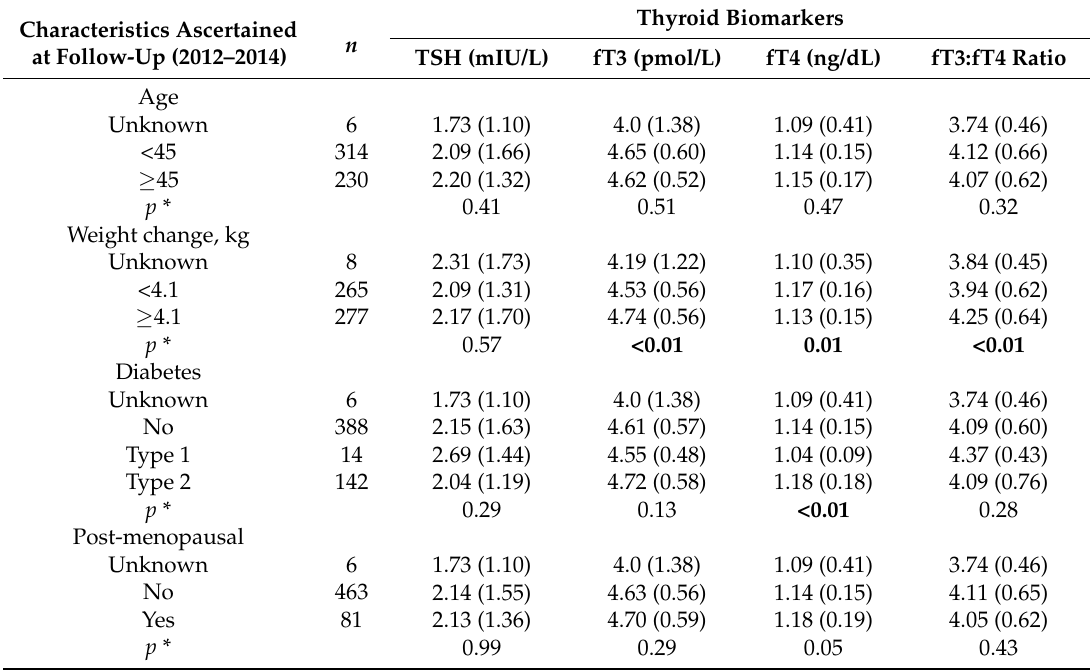
Table A1. Thyroid biomarkers according to participant characteristics at follow-up (2012–2014). Characteristics Ascertained